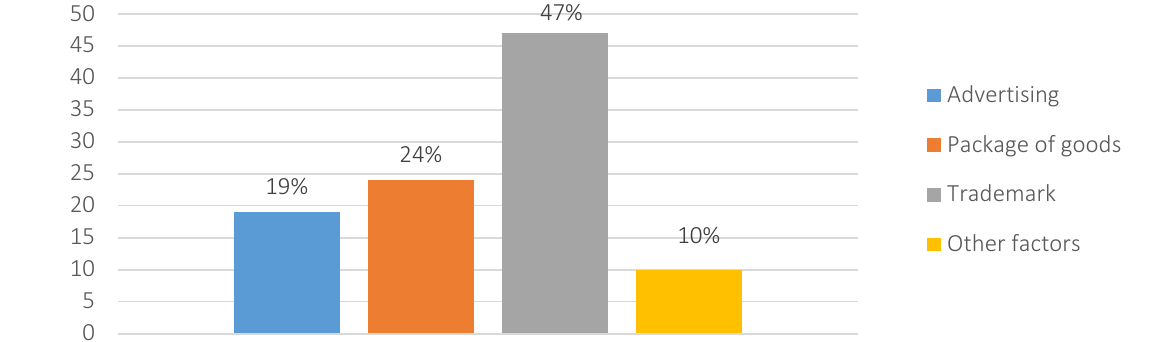
Figure 1. The respondents’ answers to the question